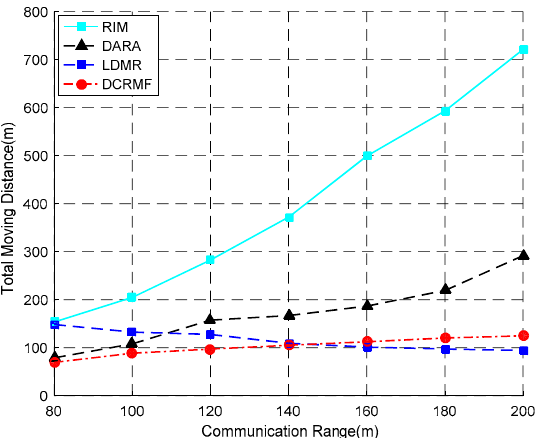
Figure 11. The relationship between the total moving distance and the communication range by using the four algorithms. Table 6. Comparison of different methods on the change of total moving distance with the communication range varying.